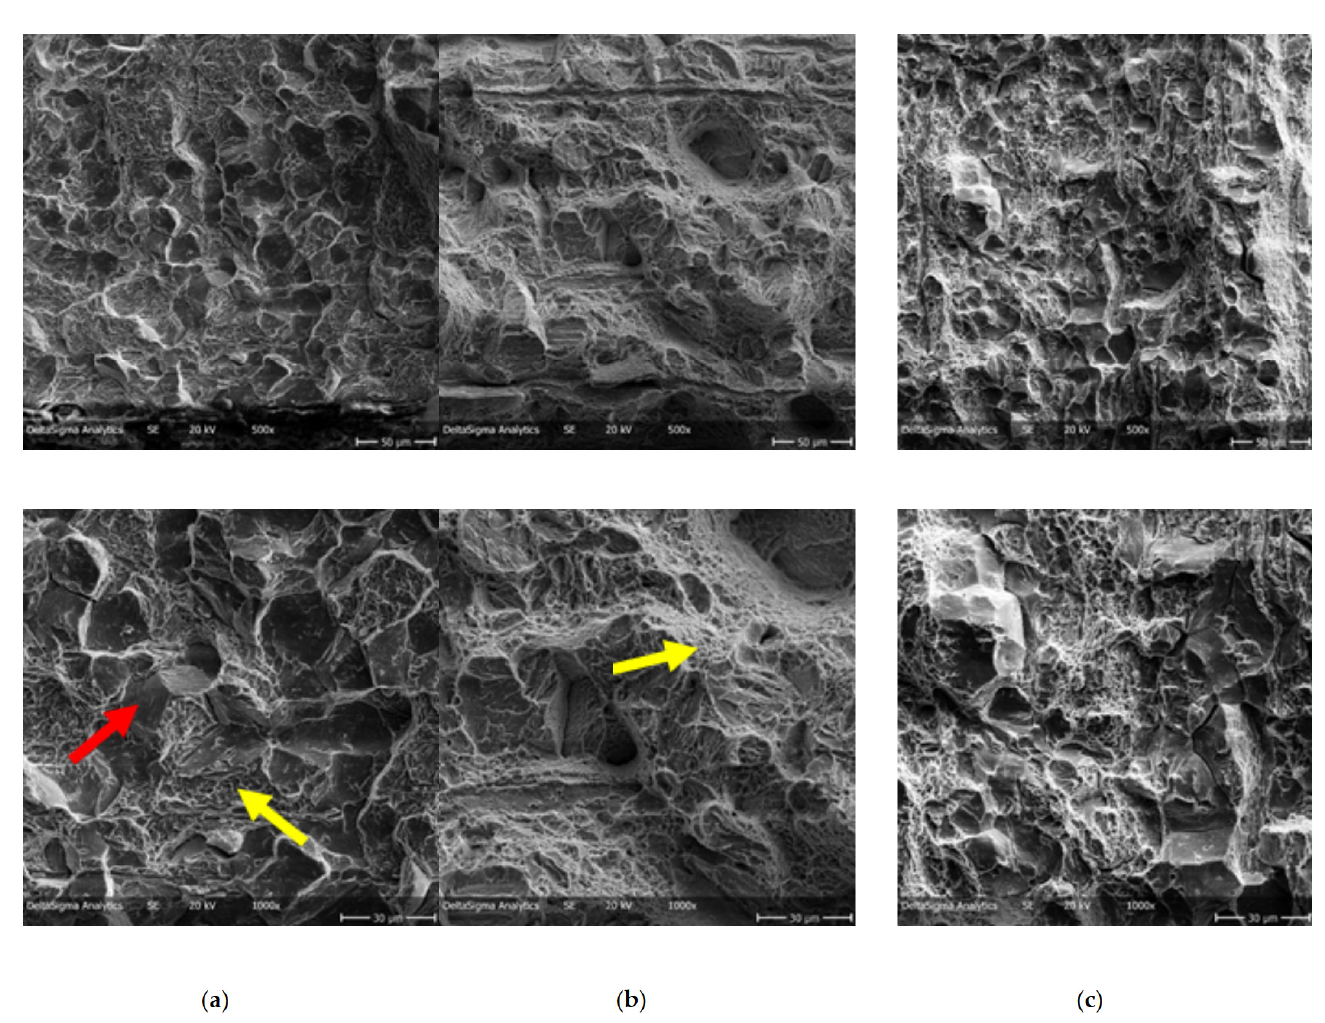
Figure 5. Fracture surfaces of tensile specimens: ( a ) Q&P 1; ( b ) Q&P 2; ( c ) Q&P 3: While condition 1 ( a ) and 3 ( c ) show both, areas of ductile fracture (yellow arrow) and brittle fracture (red arrow), condition 2 ( c ) mainly shows ductile fracture.